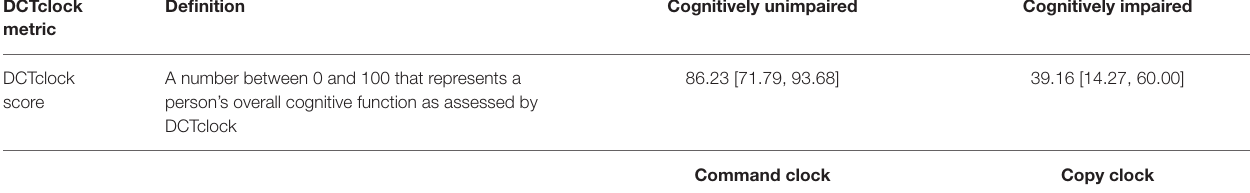
TABLE 2 | Table of DCTclock metrics with definitions and median